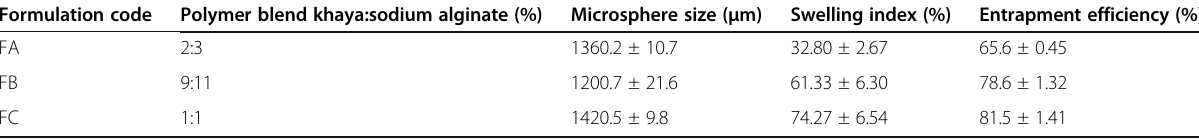
Table 4 Physicochemical properties of microspheres Formulation